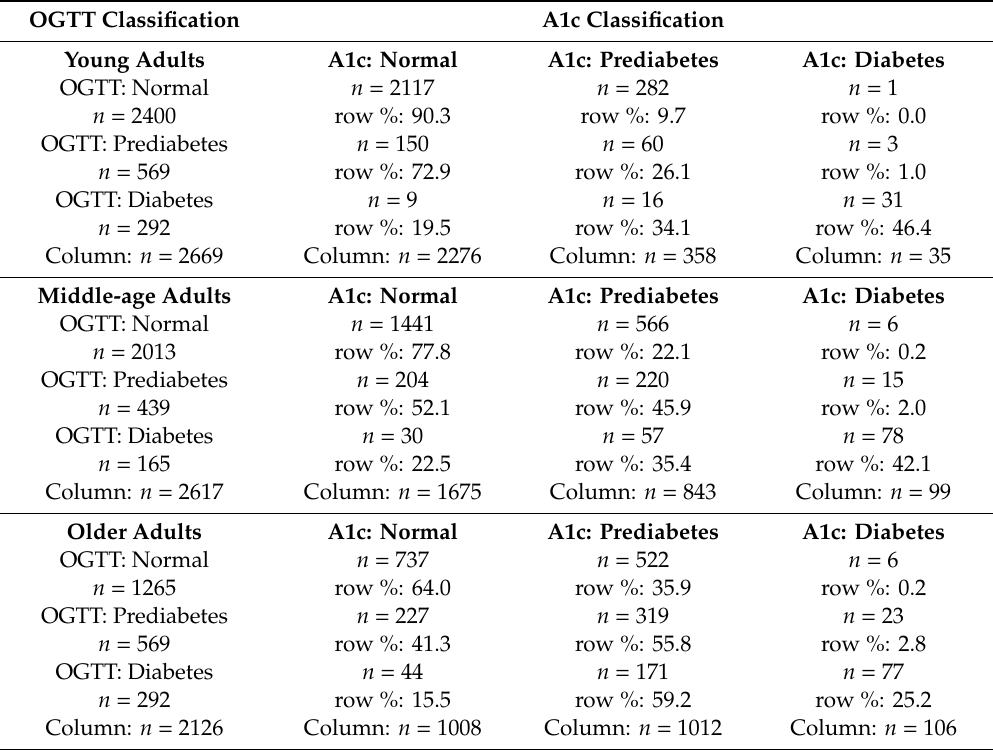
Table 3. Agreement between diabetes classifications based on the OGTT and the A1c in U.S. adults analyzed by age group,